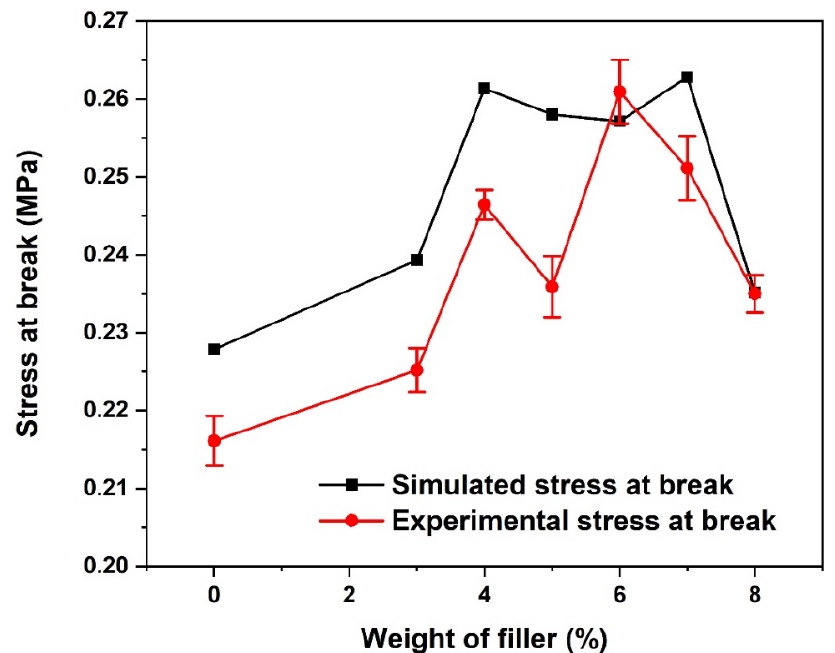
Figure 7. Stress at break of CCP-PLA nanofibre.